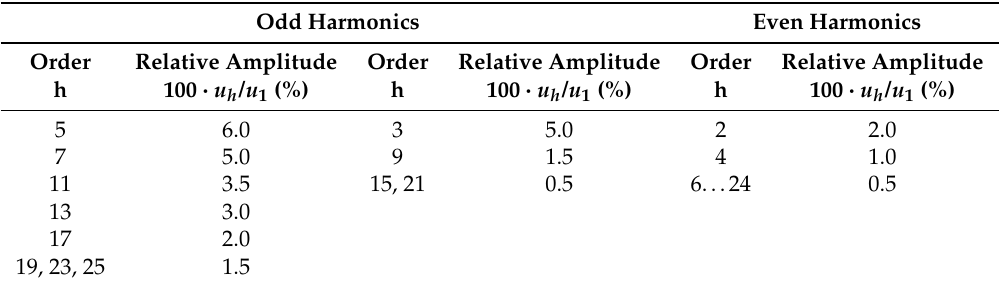
Table 3. Maximum harmonic voltage distortion at supply points (up to harmonic order 25) [22]. Odd Harmonics Even Harmonics Order Relative Amplitude Order Relative Amplitude Order Relative